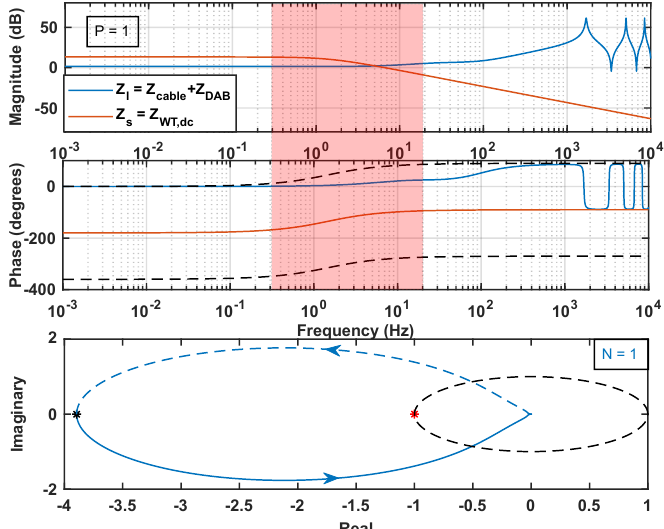
Figure 20. Stability Analysis for Single WT at P 1